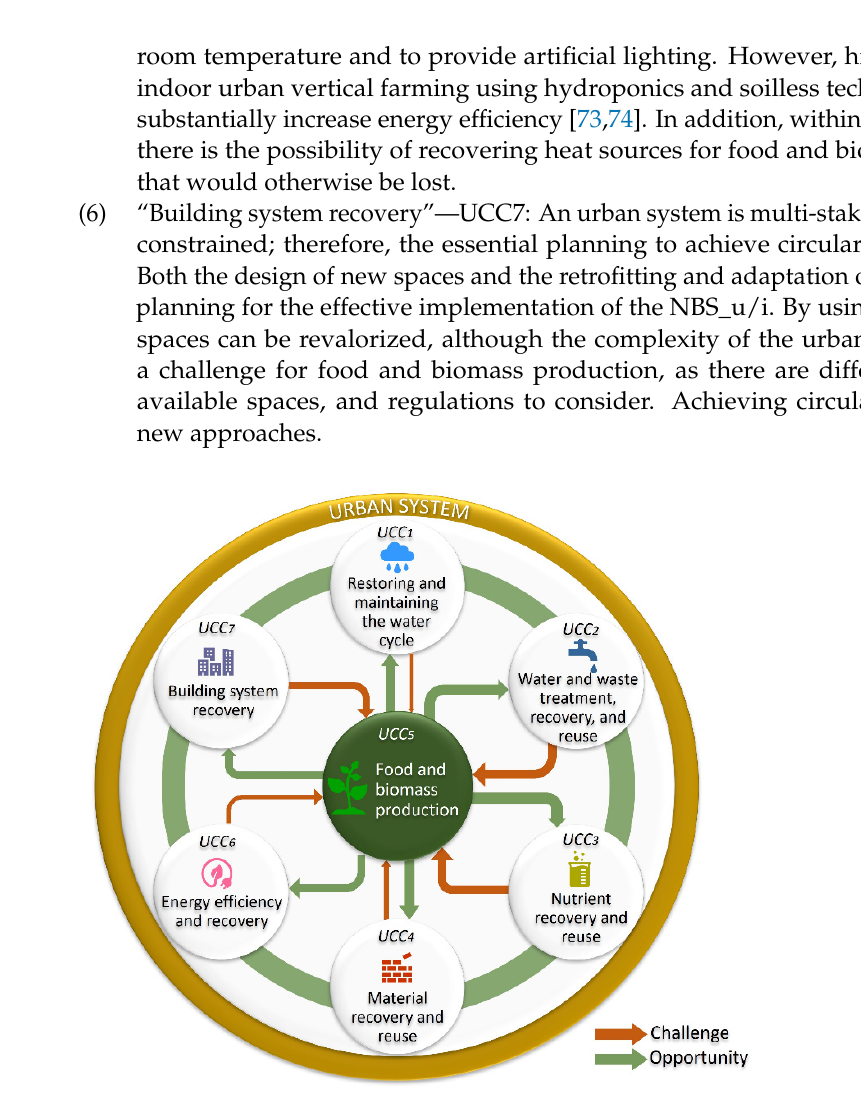
Figure 4. Relationships among food and biomass production and other urban circularity challenges described by Atanasova et al. [5–7]. The thickness of the arrows indicates the relevance of the opportunity or challenge, respectively. UCC: ( 1 ) Restoring and maintaining the water cycle (by rainwater management); ( 2 ) water and waste treatment, recovery, and reuse; ( 3 ) nutrient recovery and reuse; ( 4 ) material recovery and reuse; ( 5 ) food and biomass production; ( 6 ) energy efficiency and recovery; and ( 7 ) building system recovery [5].